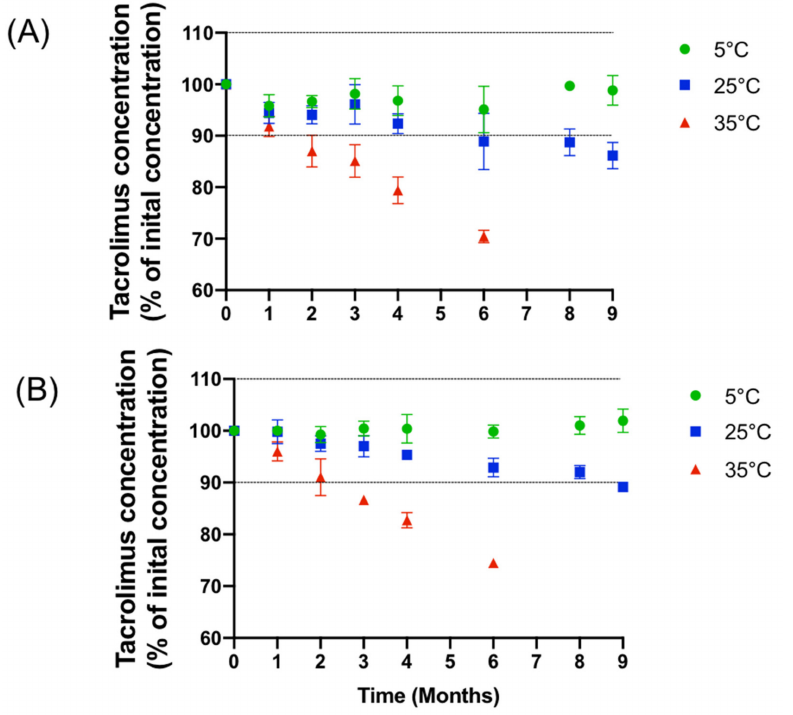
Figure 2. Evolution of the mean concentration of ( A ): 1 mg/mL and ( B ): 0.2 mg/mL formulation with IC 95% during nine months at various storage